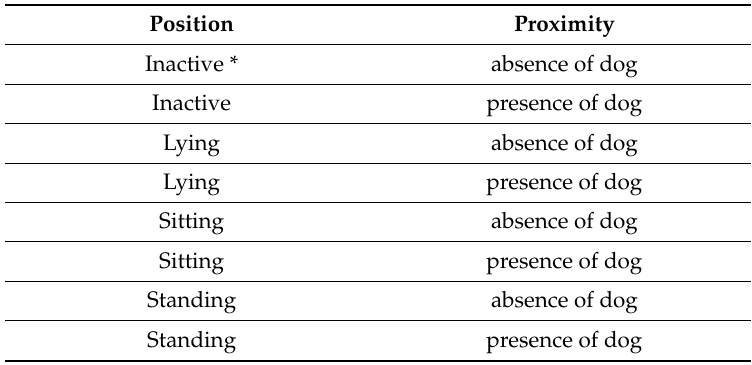
Table 3. Heart rate variability